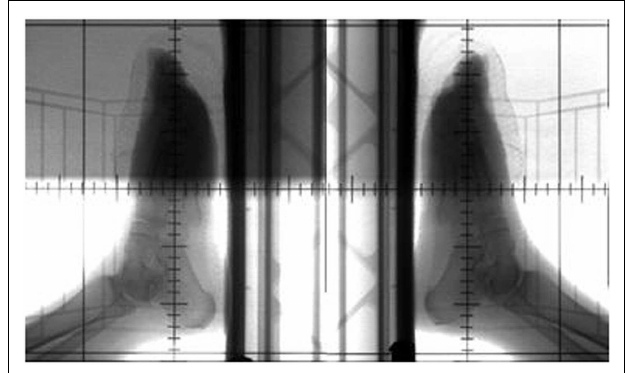
FIGURE 3 |Acuity simulation films for patient C .